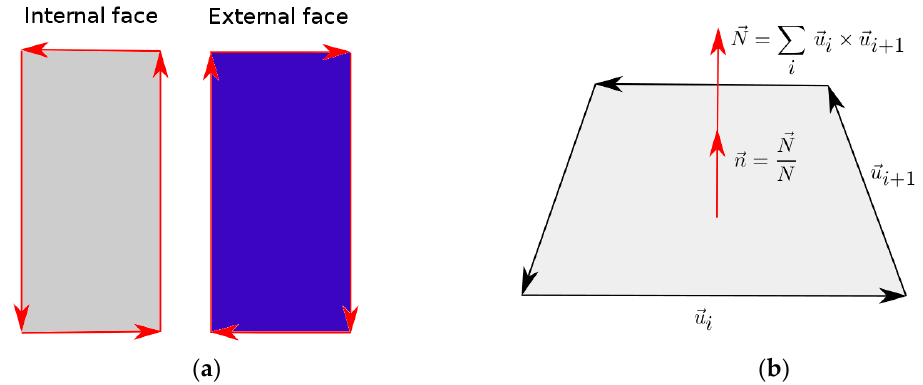
Figure 3. ( a ) Counter-clockwise oriented face ( left ): Inside, reflective surface. Clockwise oriented face ( right ): Outside, non-reflective surface. Every flat convex polygon has two faces, which can be distinguished by the orientation of the ordered vertices; ( b ) adding the cross vectors between successive polygon edge vectors is a simple and robust way to compute a perpendicular vector N, which can then be normalized, dividing by its length. The polygon must be flat, convex, and the vertices must be ordered.